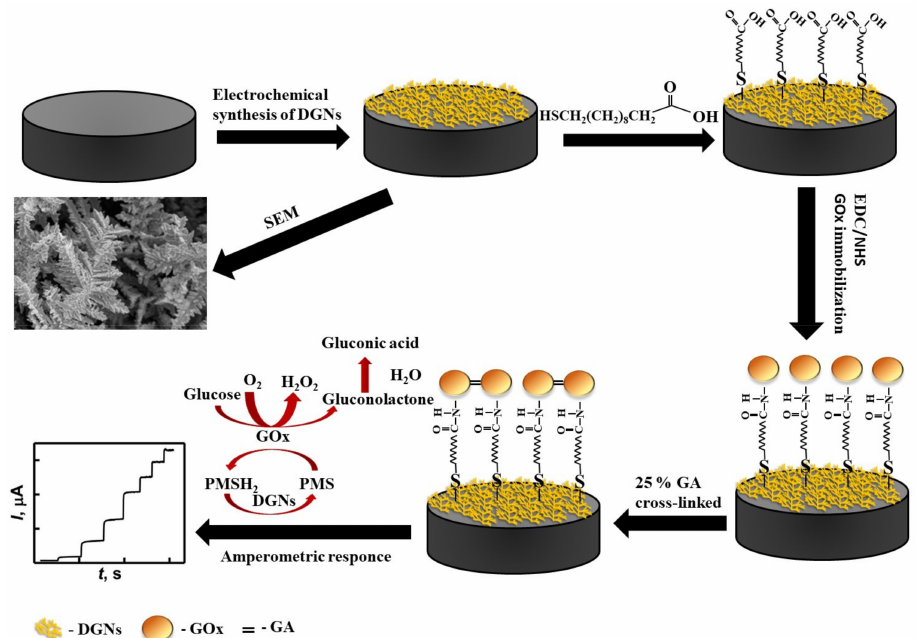
Scheme 1. Schematic representation of the modification of the GR electrode by DGNs, immo- bilization of GOx using the third method, and electrochemical determination of glucose by the developed